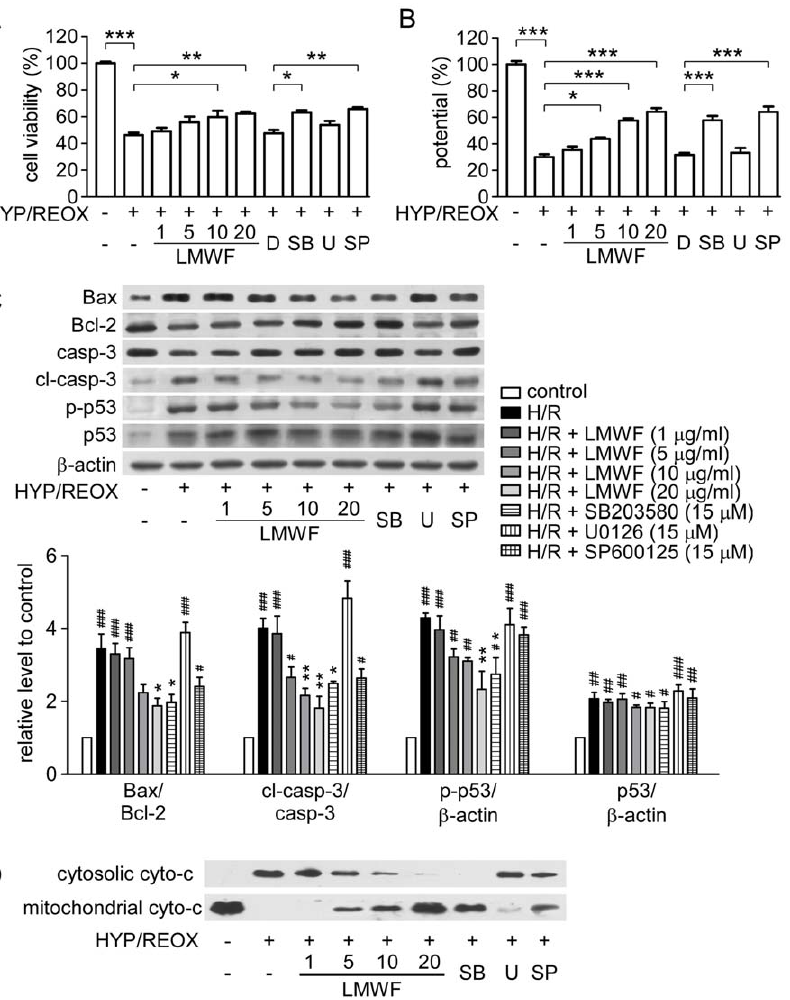
Figure 5. LMWF protected HK2 cells during hypoxia-reoxygenation. HK2 cells were exposed to hypoxia for 12 h by using the MGC AnaeroPack System. After hypoxia, cells were maintained in complete medium for 3 h with 1 , 20 m g/ml LMWF or MAPK inhibitors, SB-203580 (SB), U- 0126 (U), SP-600125 (SP), at 15 m M, or DMSO (D) as a control. (A) Cell viability was assayed using CCK8 kit. Data are mean 6 SEM. n=4. * P , 0.05, ** P , 0.01, *** P , 0.001. (B) Effect of LMWF and MAPK inhibitors on dissipation of DY m in HK2 cells. Bar diagram shows ratio of red fluorescence to green fluorescence. Data are mean 6 SEM. n=4. * P , 0.05, ** P , 0.01, *** P , 0.001. (C) Representative blottings ( up ) and relative ratios of protein levels ( down ) are shown. Each bar represents the mean 6 SEM. n=3; # P , 0.05, ## P , 0.01, ### P , 0.001 vs. control, * P , 0.05, ** P , 0.01 vs. hypoxia- reoxygenation group. (D) Representative Western blottings of mitochondrial and cytosolic cyto-c are shown.